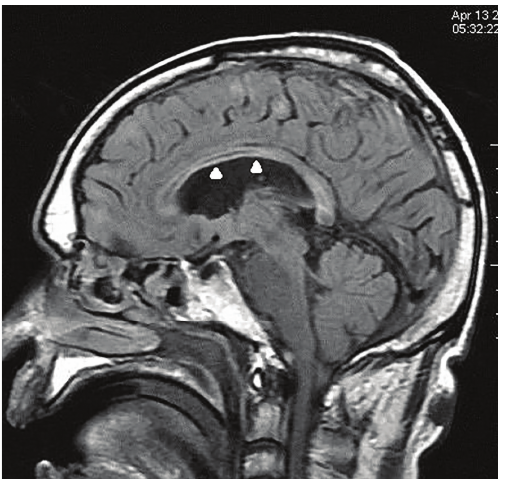
Figure 5: Post-Gadolinium axial T1 weighted image showing lack of enhancement of the hypointense lesions involving the corpus callosum (white arrow).